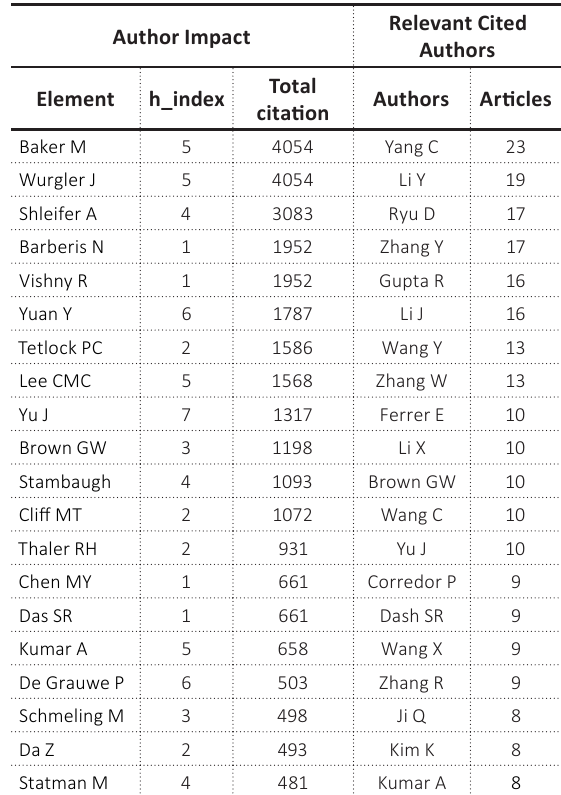
Table 4. Top 20 most relevant authors,